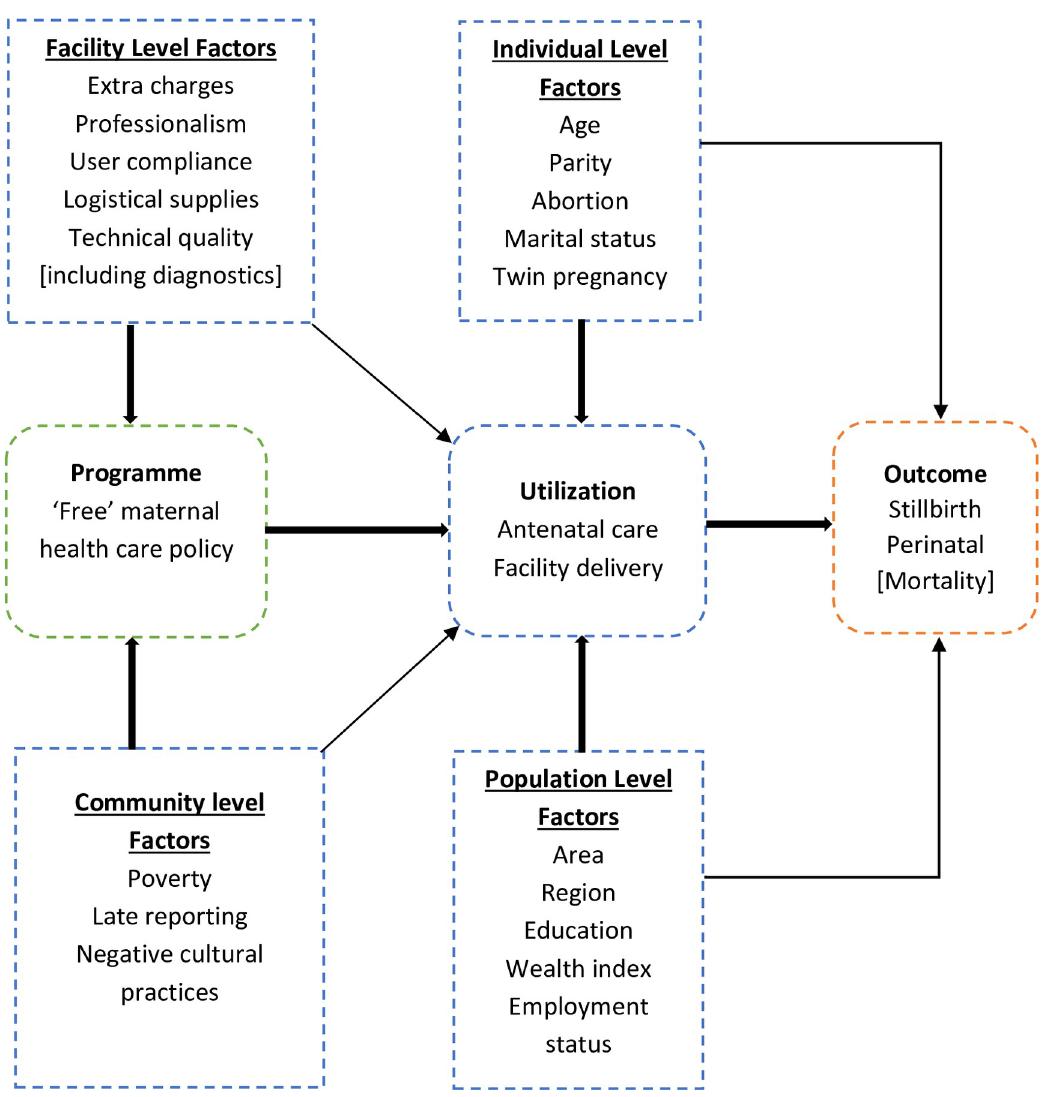
Fig 1. Conceptual framework: Multifaceted factors moderating stillbirth and perinatal mortality. and end line, respectively. The two-rounds of DHS data sets were merged, and two groups cre- ated: the ’free’ maternal health care policy group and the ‘no-free’ maternal health care policy